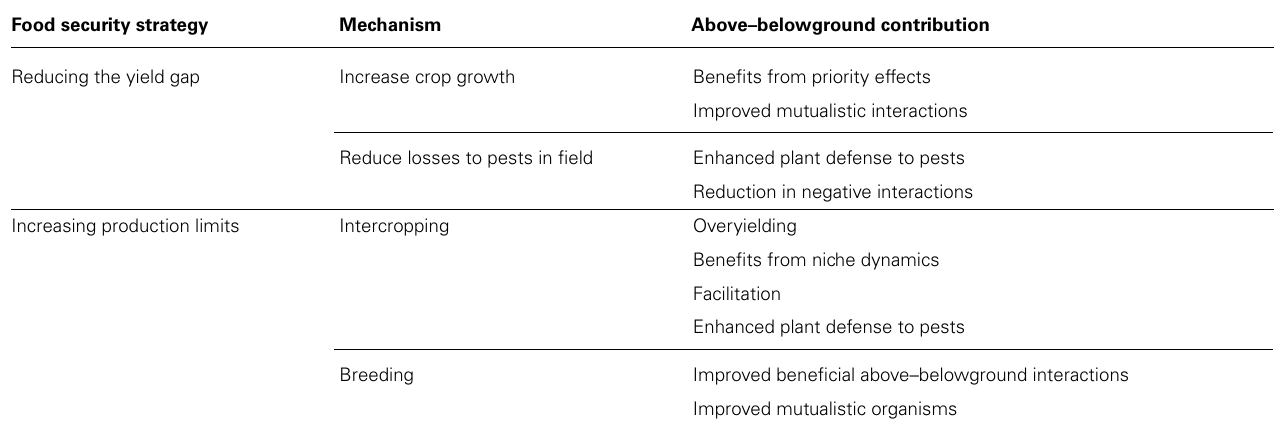
Table 1 |Table listing the various mechanisms that could be used to address the two food security strategies addressed in this manuscript, and the potential contributions above–belowground interactions could make to these